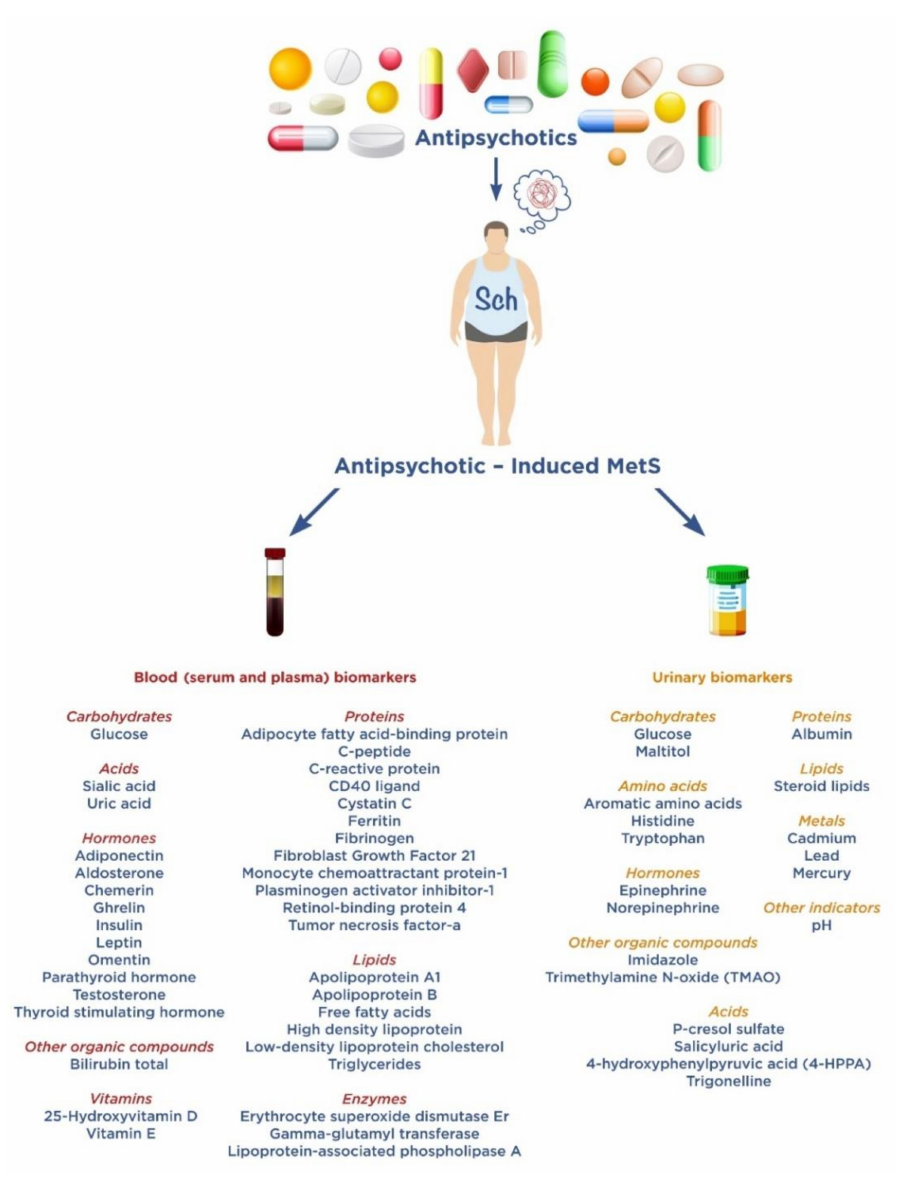
Figure 2. Potential Blood (Serum and Plasma) and Urinary Biomarkers of Antipsychotics—Induced Metabolic Syndrome (AIMetS) in Patients with Schizophrenia